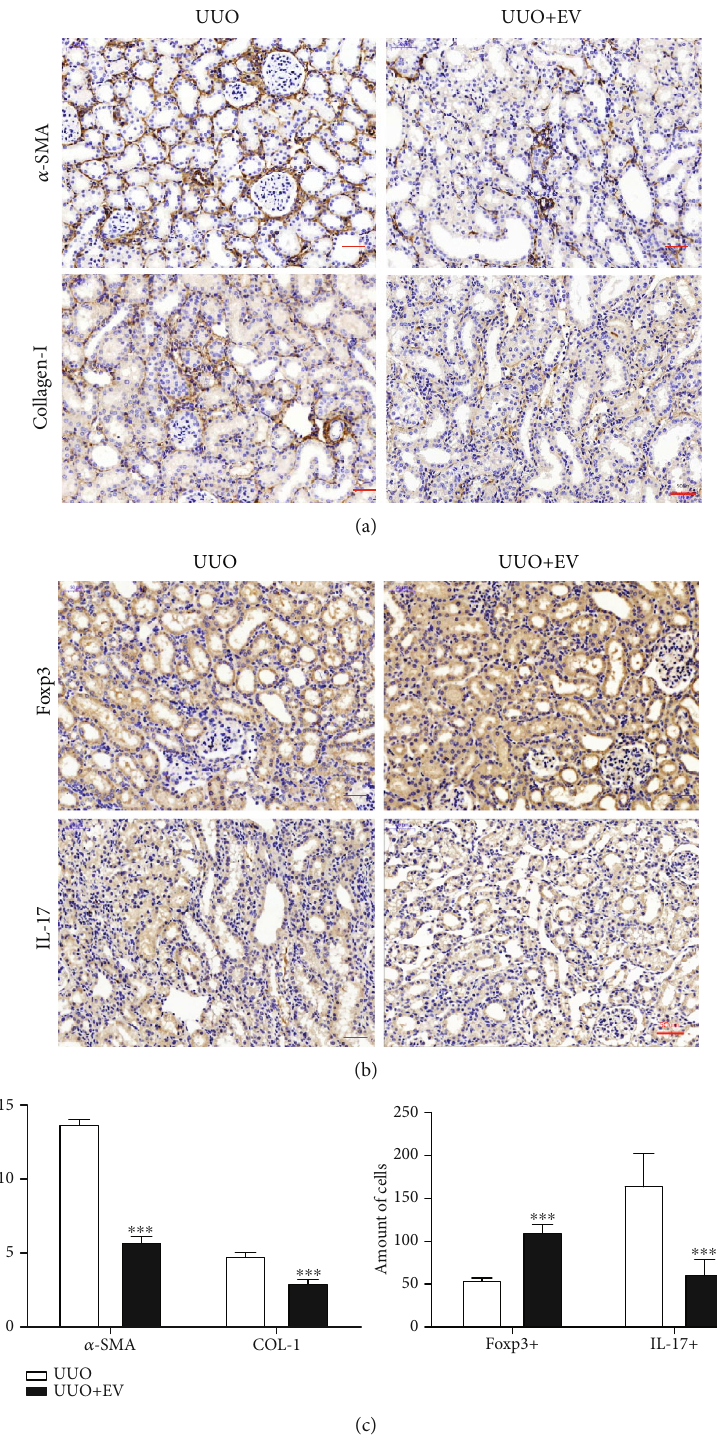
Figure 6: PMSC-EVs treatment attenuate tubulointerstitial fi brosis and increase Foxp3 expression by downregulating IL17 expression in vivo. (a) IHC for detecting α -SMA and COL-I expression in rat renal tissues from the UUO group and UUO+EV treatment group. Scale bar: 50 μ m. (b) IHC for Foxp3 and IL-17 in rat renal tissue sections 7 days after UUO with or without PMSC-EVs treatment. Scale bar: 50 μ m. (c) Fibrosis area and Foxp3 and IL17 positive cells in representative images from (a) and (b) were analyzed by Image J software. Error bars are ± SD. ∗ P < 0 : 05 compared with the UUO group; ∗∗ P < 0 : 01 compared with the UUO group. ∗∗∗ P < 0 : 001 compared with UUO group. (d) IF for identi fi cation of Foxp3 + T cells in fi ltration in renal tissue after UUO 7 days with or without PMSC-EVs treatment. Scale bar: 50 μ m. (e) Representative IF staining pictures of IL-17 + T cells in the UUO group and UUO+EV group. Scale bar: 50 μ